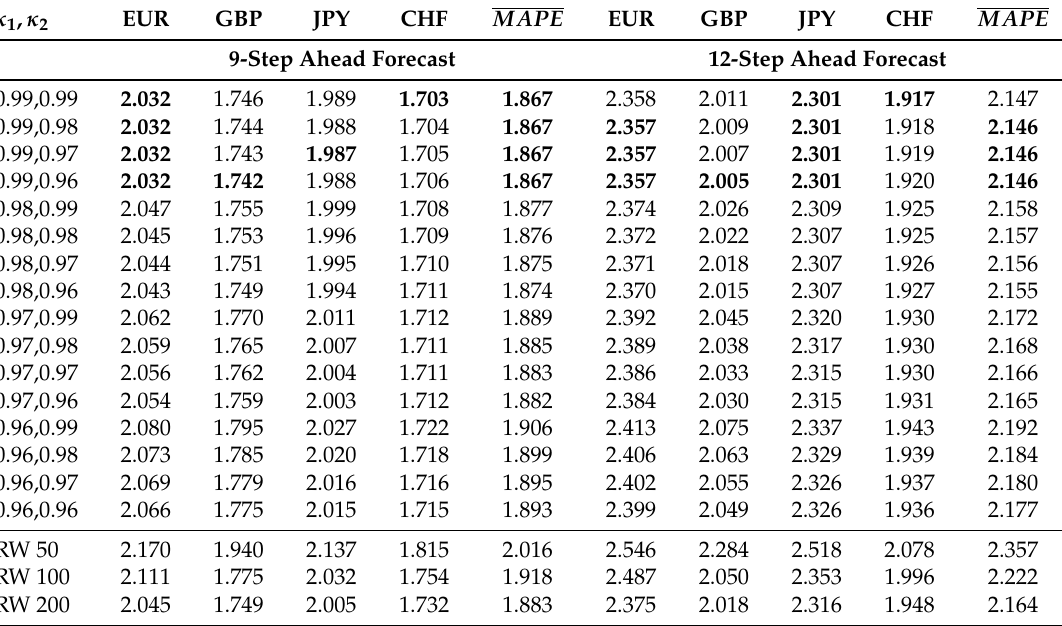
Table 5. Forecast comparison using MAPE